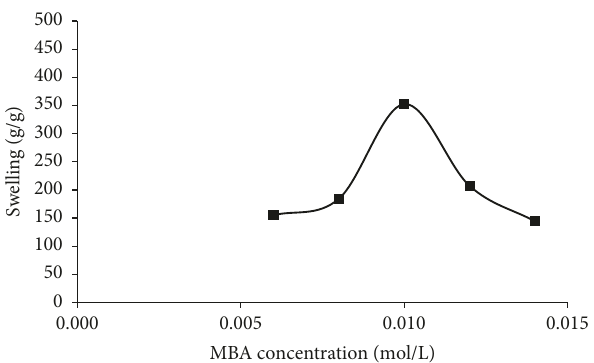
Figure 5: Effect of MBA on swelling capacity (reaction condition: 2.0 g/100mL NaCMC, 0.8 mol/L AA, 70% neutralized AA, and 0.014 mol/L KPS at 70 ∘ C for 90 min).